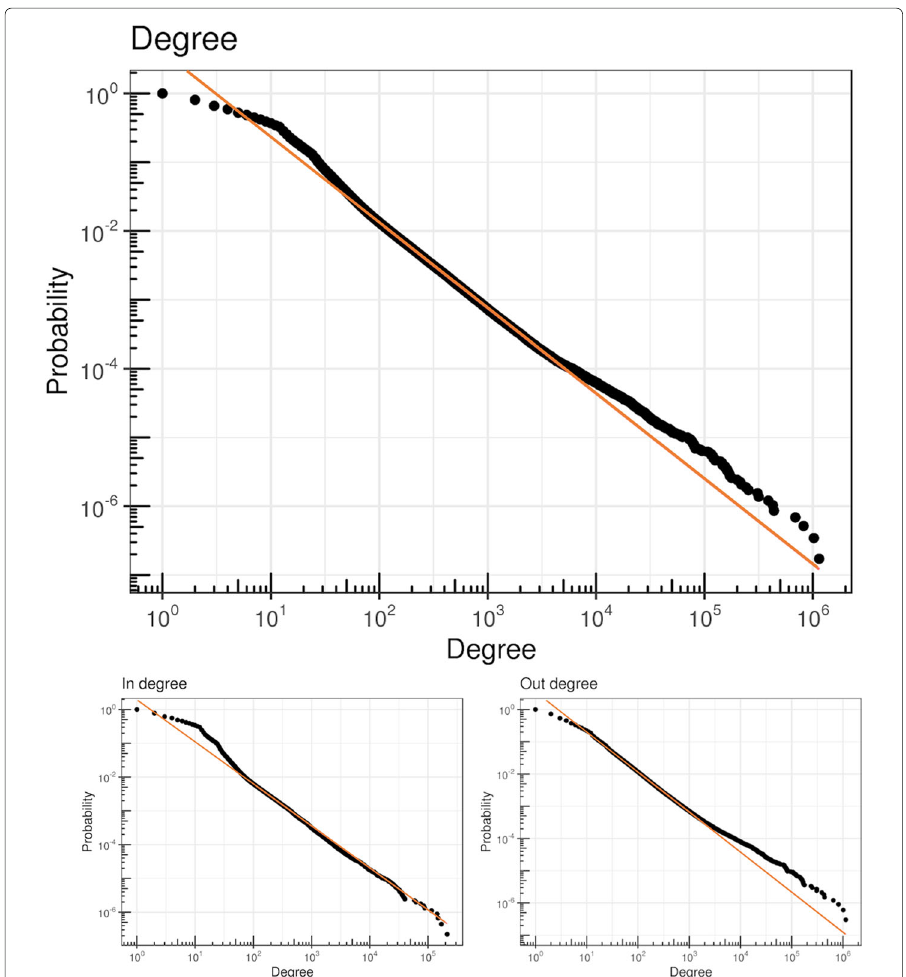
Fig. 5 Degree distribution Log-log plots of the degree distribution for the 2017 wire transfer network: top (total degree), bottom-left (in-degree) and bottom-right (out-degree). The slope of the fitting red line is between 2 and 3. Fitting line plotted even before xmin obtained from PoweRlaw library: xmin total = 111, xmin in-degree = 93, xmin out-degree =